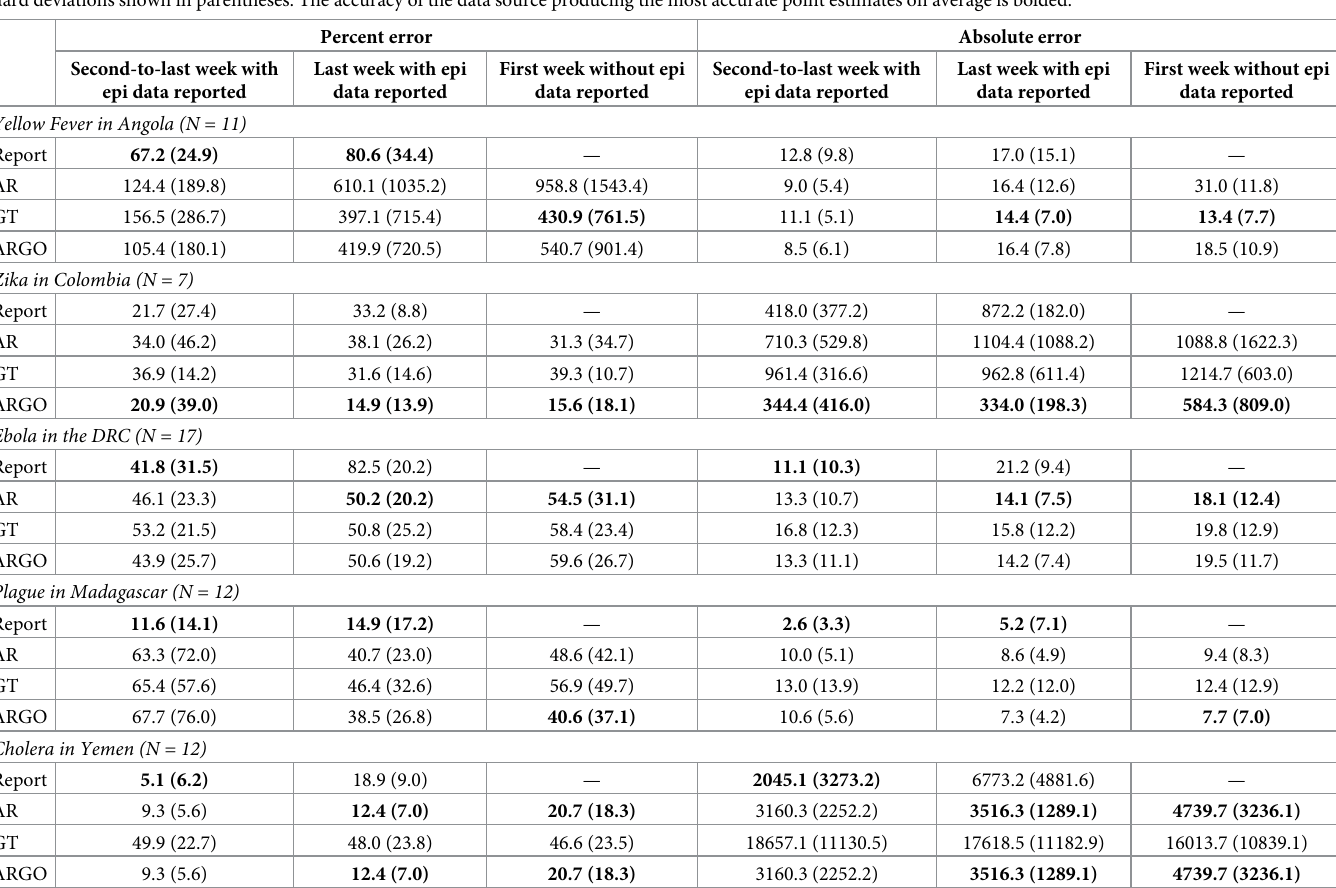
Table 2. Comparison of cases reported in epidemiological bulletins to projections produced by our nowcasting models in real-time. Accuracy is measured in compar- ison to the ground-truth case counts eventually reported at the end of each outbreak. Accuracy of each model is calculated separately for the second-to-last week with epi- demiological data reported in each bulletin, the last week with epidemiological data reported, and the first week without any epidemiological data reported (we do not evaluate longer time horizons since in several outbreaks epidemiological bulletins are produced near-weekly, rendering projections based on previous bulletins obsolete). Accuracy measures are then averaged over epidemiological bulletins for each outbreak (ranging from seven for Zika in Colombia to 17 for Ebola in the DRC), with stan- dard deviations shown in parentheses. The accuracy of the data source producing the most accurate point estimates on average is